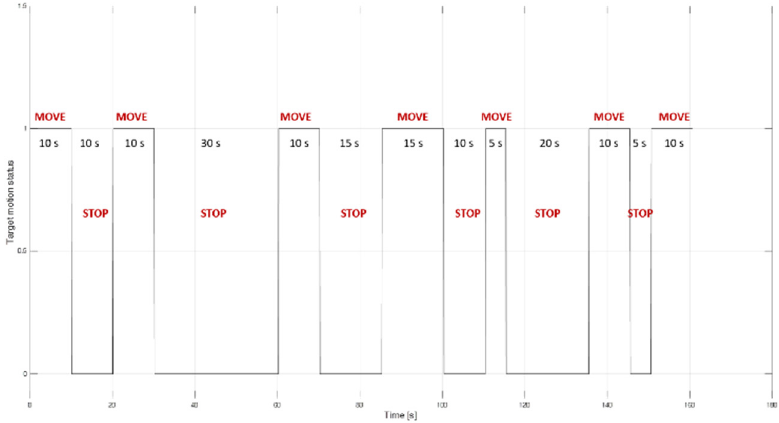
Figure 6. Target motion description: value = 1, the target is moving; value = 0, the target is stationary.